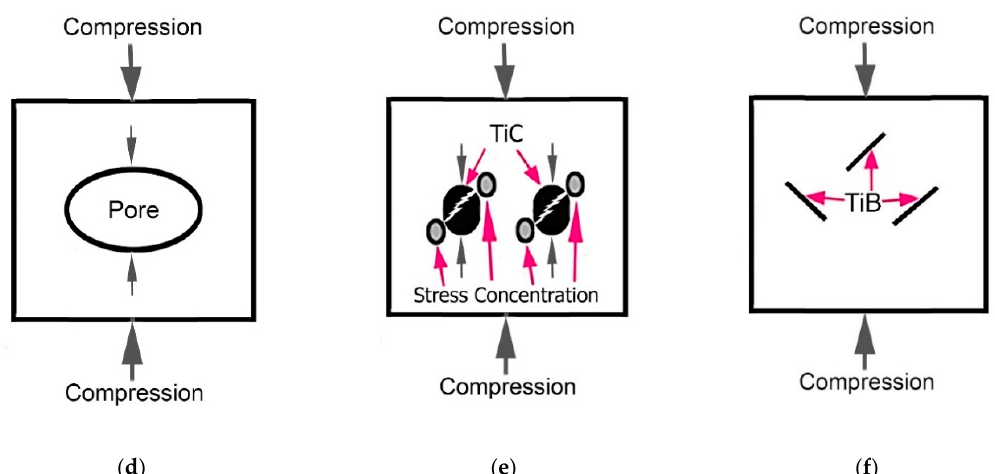
Figure 22. Schematic illustration of the stress concentration mechanisms involving pores ( a , d ), carbides ( b , e ), and borides ( c , f ) under tensile ( a – c ) and compression ( d – f ) test.